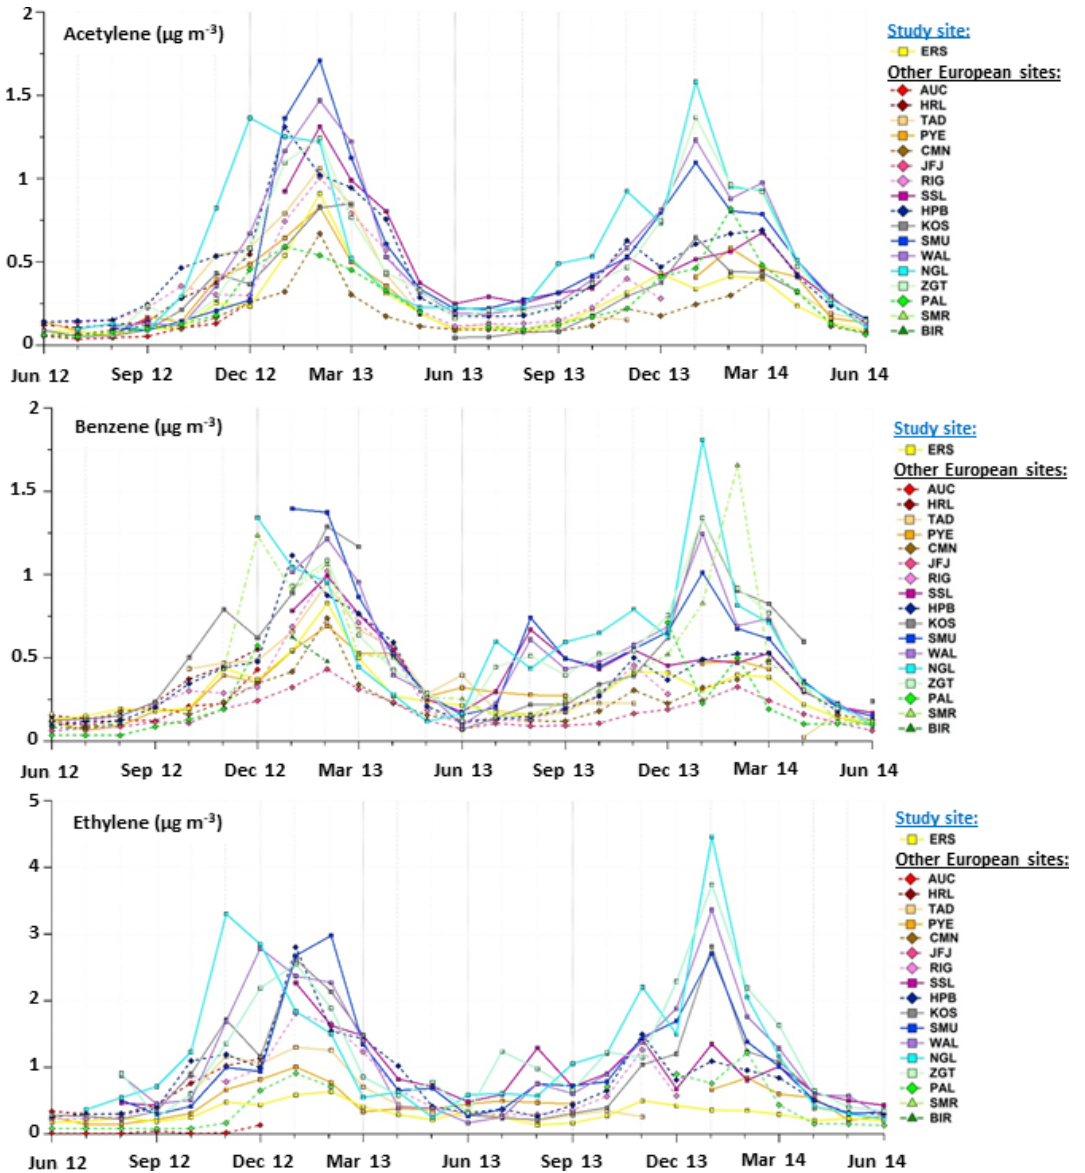
Figure 13. Monthly concentration time series of a selection of NMHCs (expressed in µgm − 3 ) measured at Ersa and 17 other European monitoring stations. Stations are indicated according to their GAW identification (see Sect. S7). “ERS” refers to the study